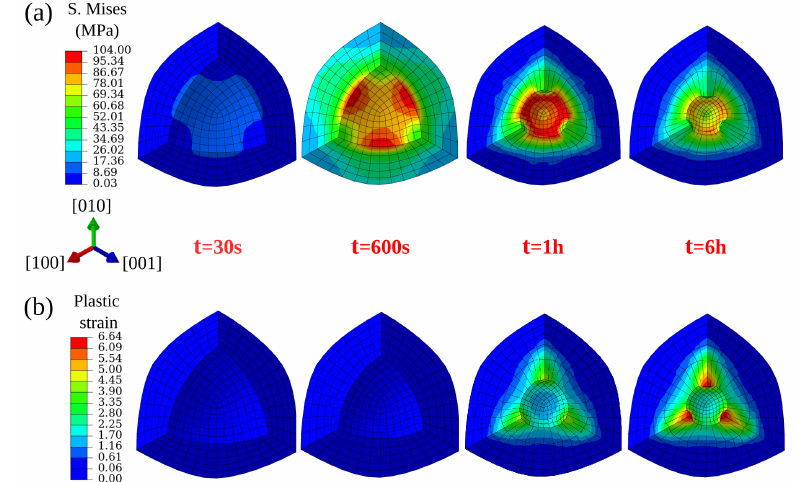
Figure 8. Von Mises stress ( a ) and plastic strain ( b ) evolution around a spherical void (zoomed area) with increasing simulation time under 100 MPa isostatic pressure at 1561 K.